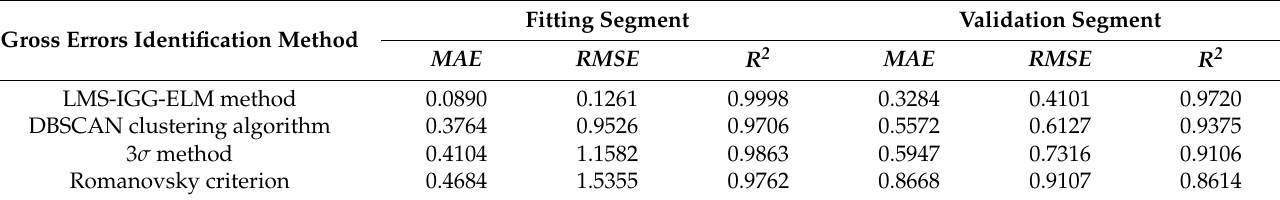
Table 6. Comparison table of evaluation